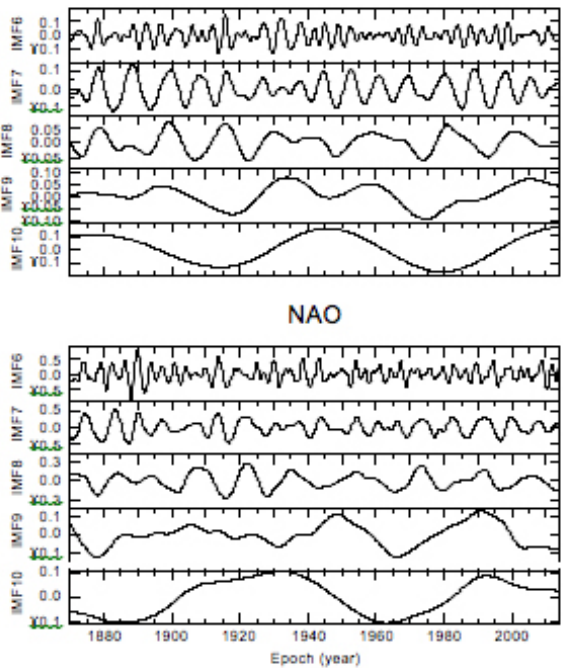
Figure 10. Image functions IMFk (k =6, ..., 10) resulting from the EEMD analysis of the NAO and AMO indices.